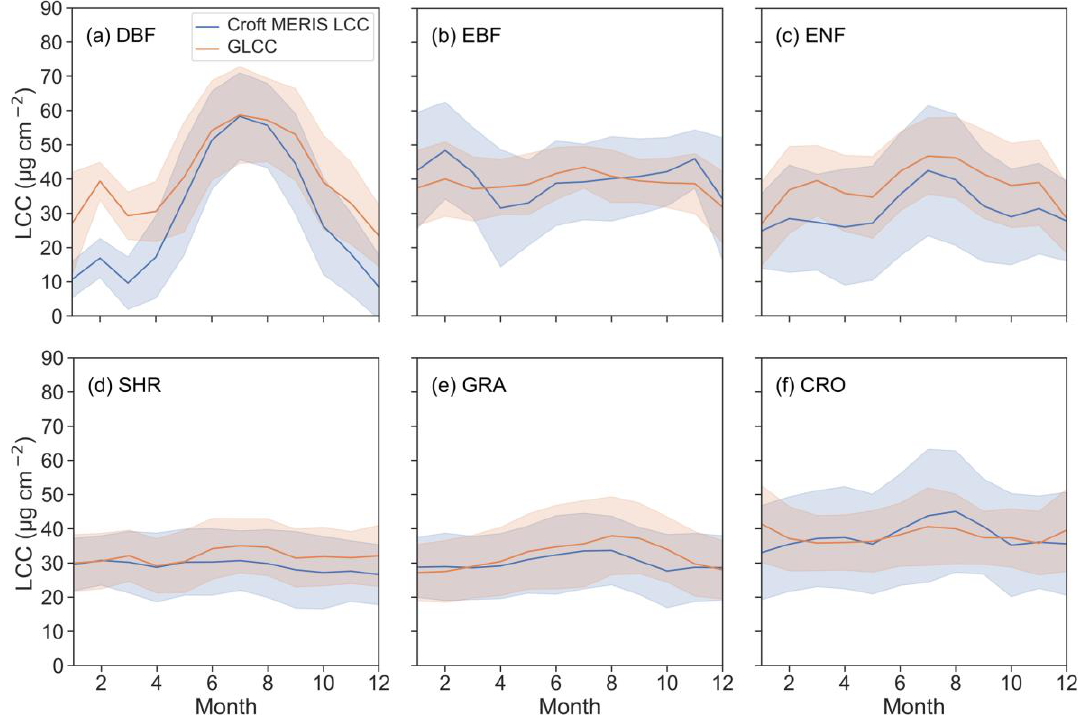
Figure 10. The mean seasonal profiles of the two LCC datasets in six different PFTs at the cross- validation sites in the northern hemisphere. The shadow areas in each subfigure represent one standard deviation.